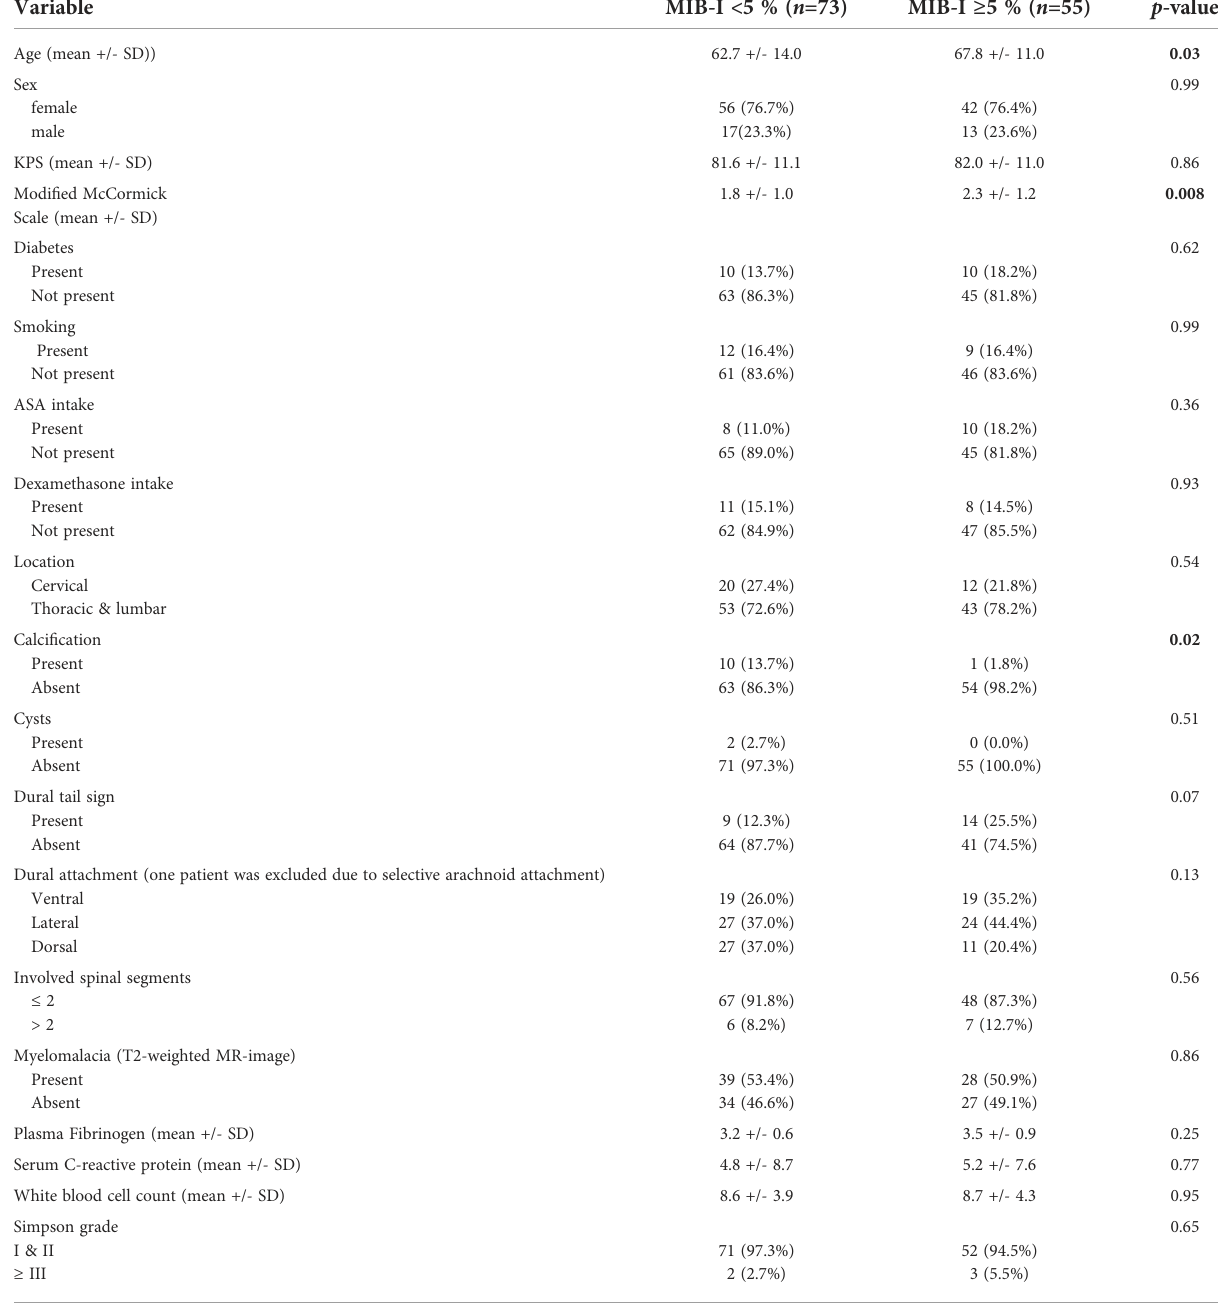
TABLE 2 Baseline clinical, imaging and laboratory characteristics in spinal meningioma patients with a normal and increased MIB-I labeling index ( n = 128).